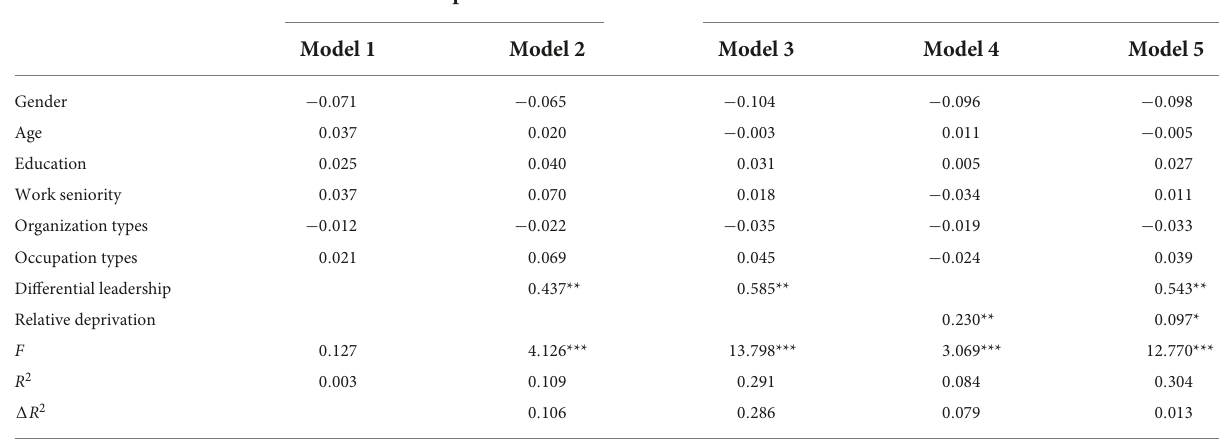
TABLE 3 Mediating effect of relative deprivation ( n =